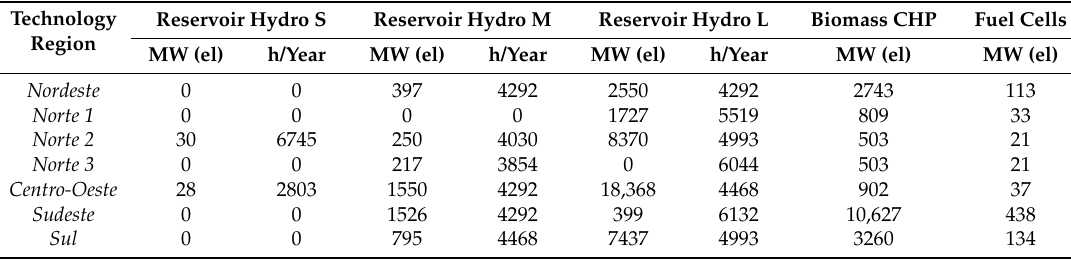
Table A5. Considered reservoir hydro and biomass power capacities and annual full load hours based on